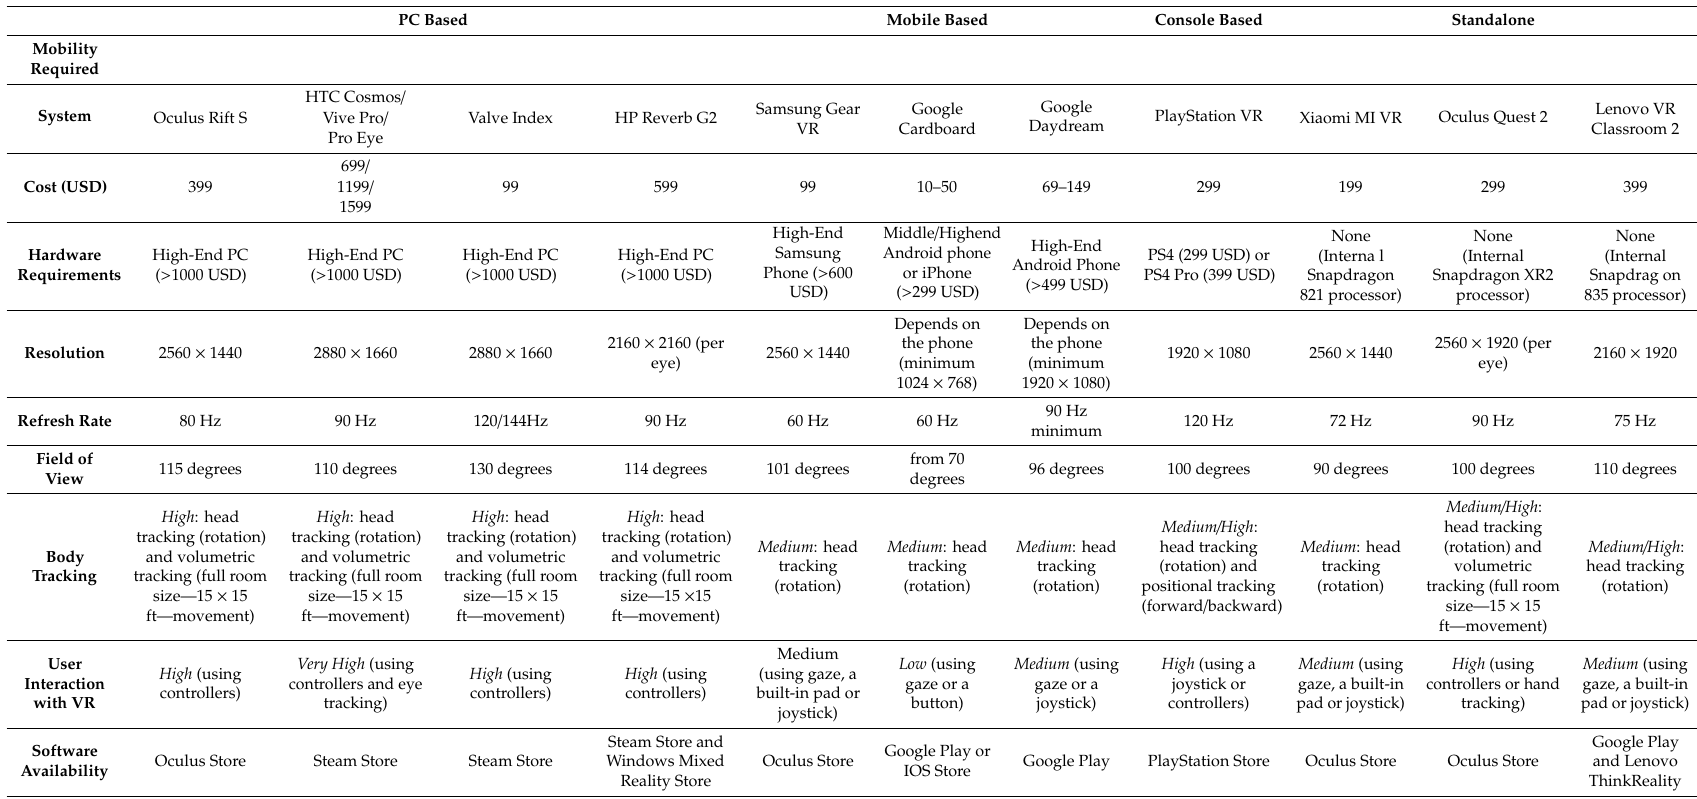
Table 1. Commercially available VR